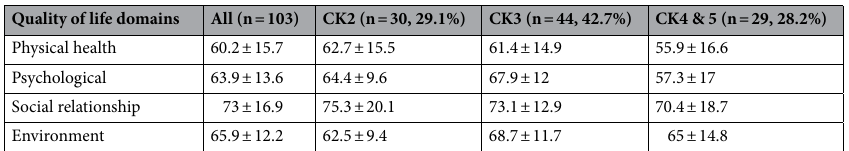
Table 5. QOL domains according to CKD